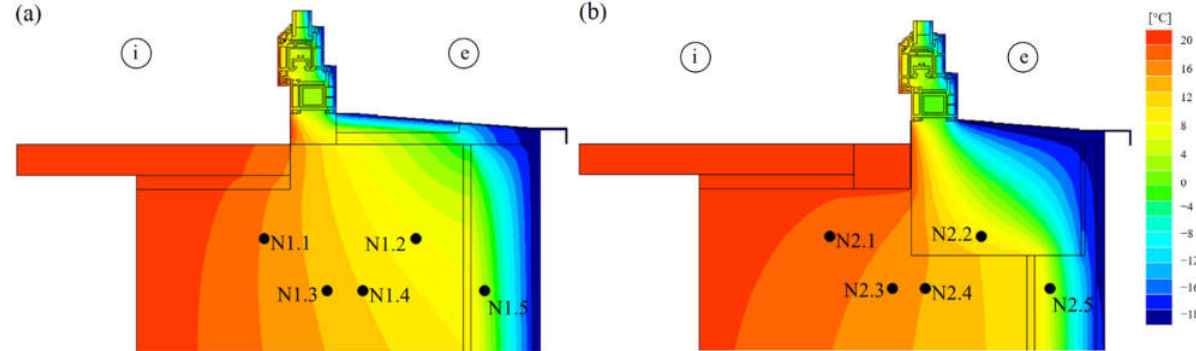
Figure 4. Temperature distribution in external wall (for bottom section) with window installed ( a ) in conventional way, ( b ) using composite frame (i—internal, e—external). There was a clear difference whereby higher temperatures, by about 2 °C, occurred transfer in this model, lower heat losses occurred at the window-to-wall interface. Similar differences were registered at the measuring points.